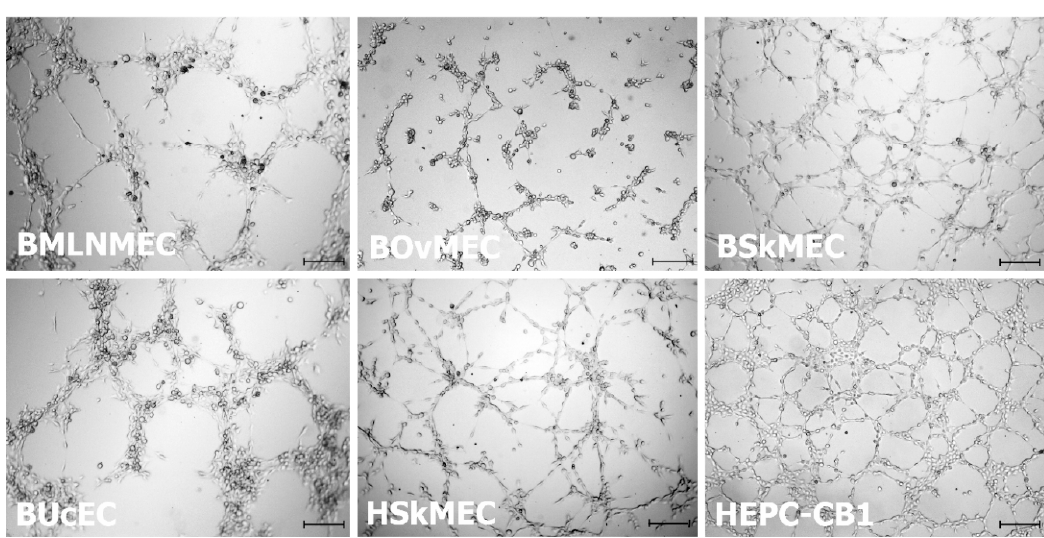
Figure 2. Bovine endothelial cell line angiogenesis assessed by pseudovessel formation on Matrigel™. Cells were seeded on Matrigel™ and angiogenesis was monitored under a video microscope during 24 h. Presented pictures are at 1.5 h (for BBrMEC, BIntMEC, and BSkMEC), at 4.5 h (for BLuMEC, BOvMEC, BUcEC, HSkMEC, and HEPC-CB1) and at 5.5 h (for BMLNMEC) after seeding. Scale bar is 200 μ m.